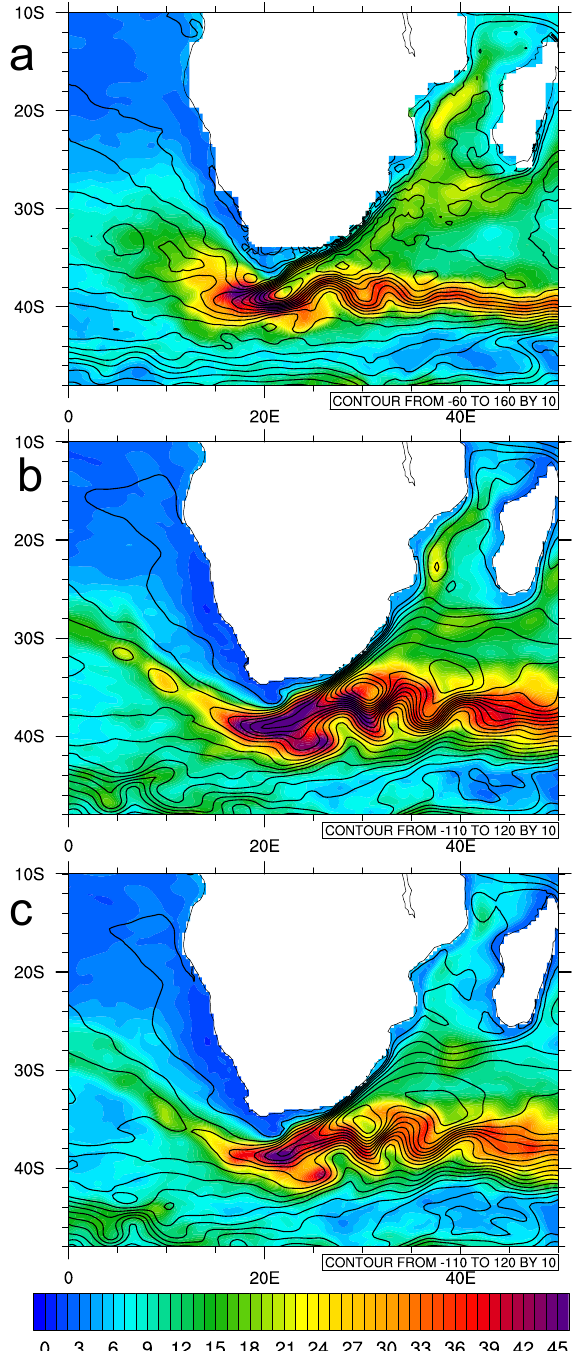
Fig. 3. Contour of mean dynamic topography and standard devia- tion (colors, in cm) from (a) satellite altimetry, (b) POP CTRL and (c) POP noITF near the tip of South Africa.